Question: Give a one-sentence summary of this figure.
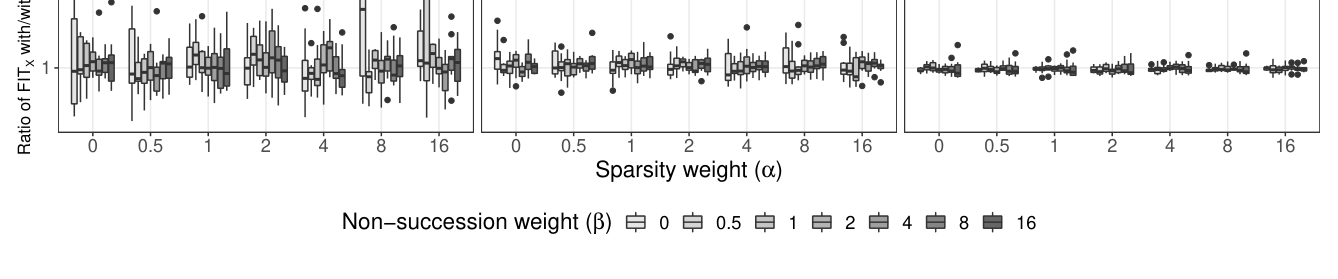
Answer: Ratio of the FITX metric with and without normalization of SWoTTeD on synthetic datasets. A ratio above 1 indicates a benefit of using normalization on the reconstruction accuracy.